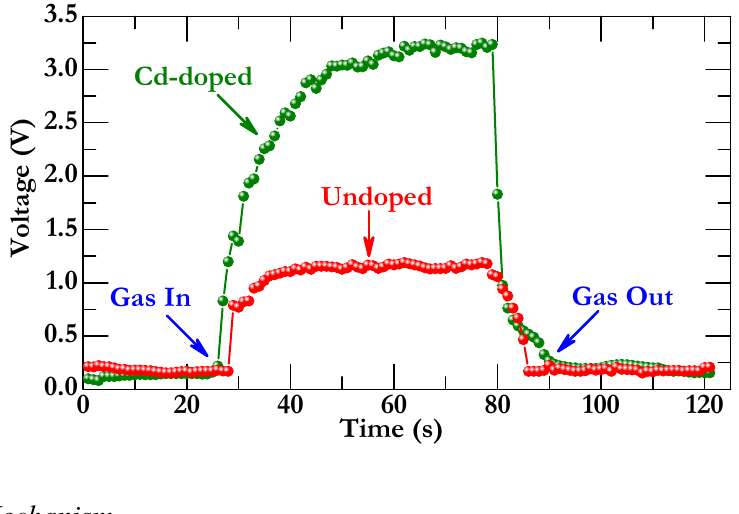
Figure 7. Response-recovery property for sensors fabricated using undoped and Cd-doped composite